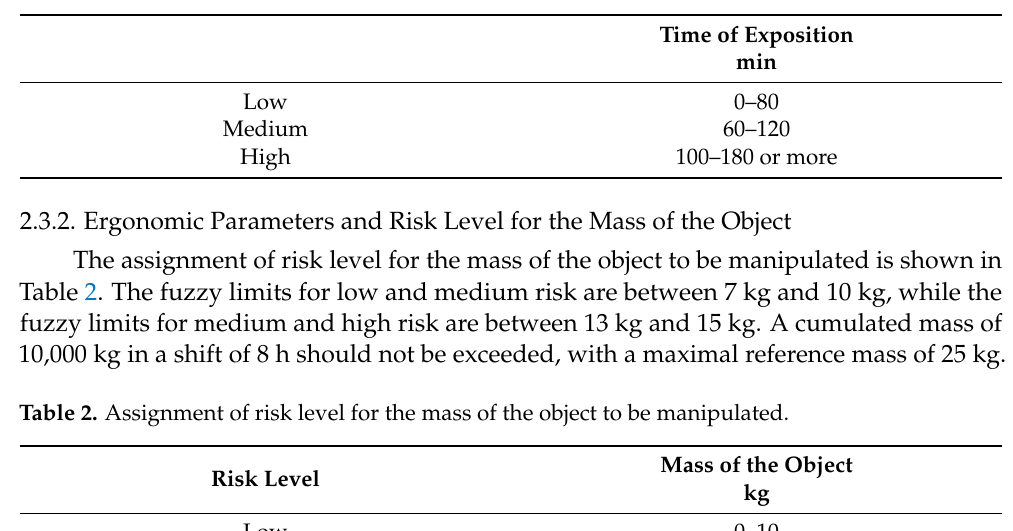
Table 1. Assignment of risk level for the time of exposition.